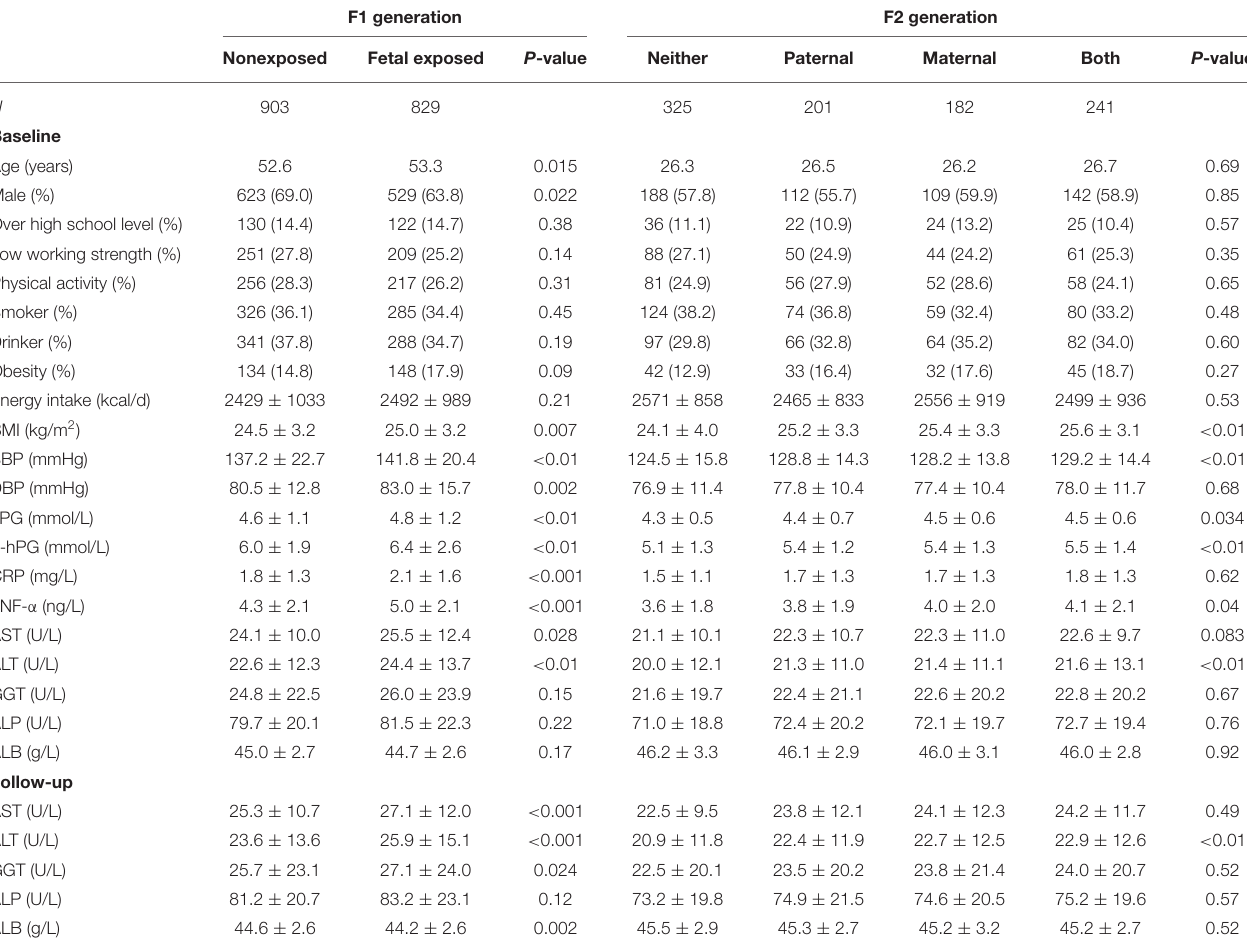
TABLE 1 | Characteristics of the study variables at baseline and follow-up in parents and their offspring. F1 generation F2 generation Nonexposed Fetal exposed P